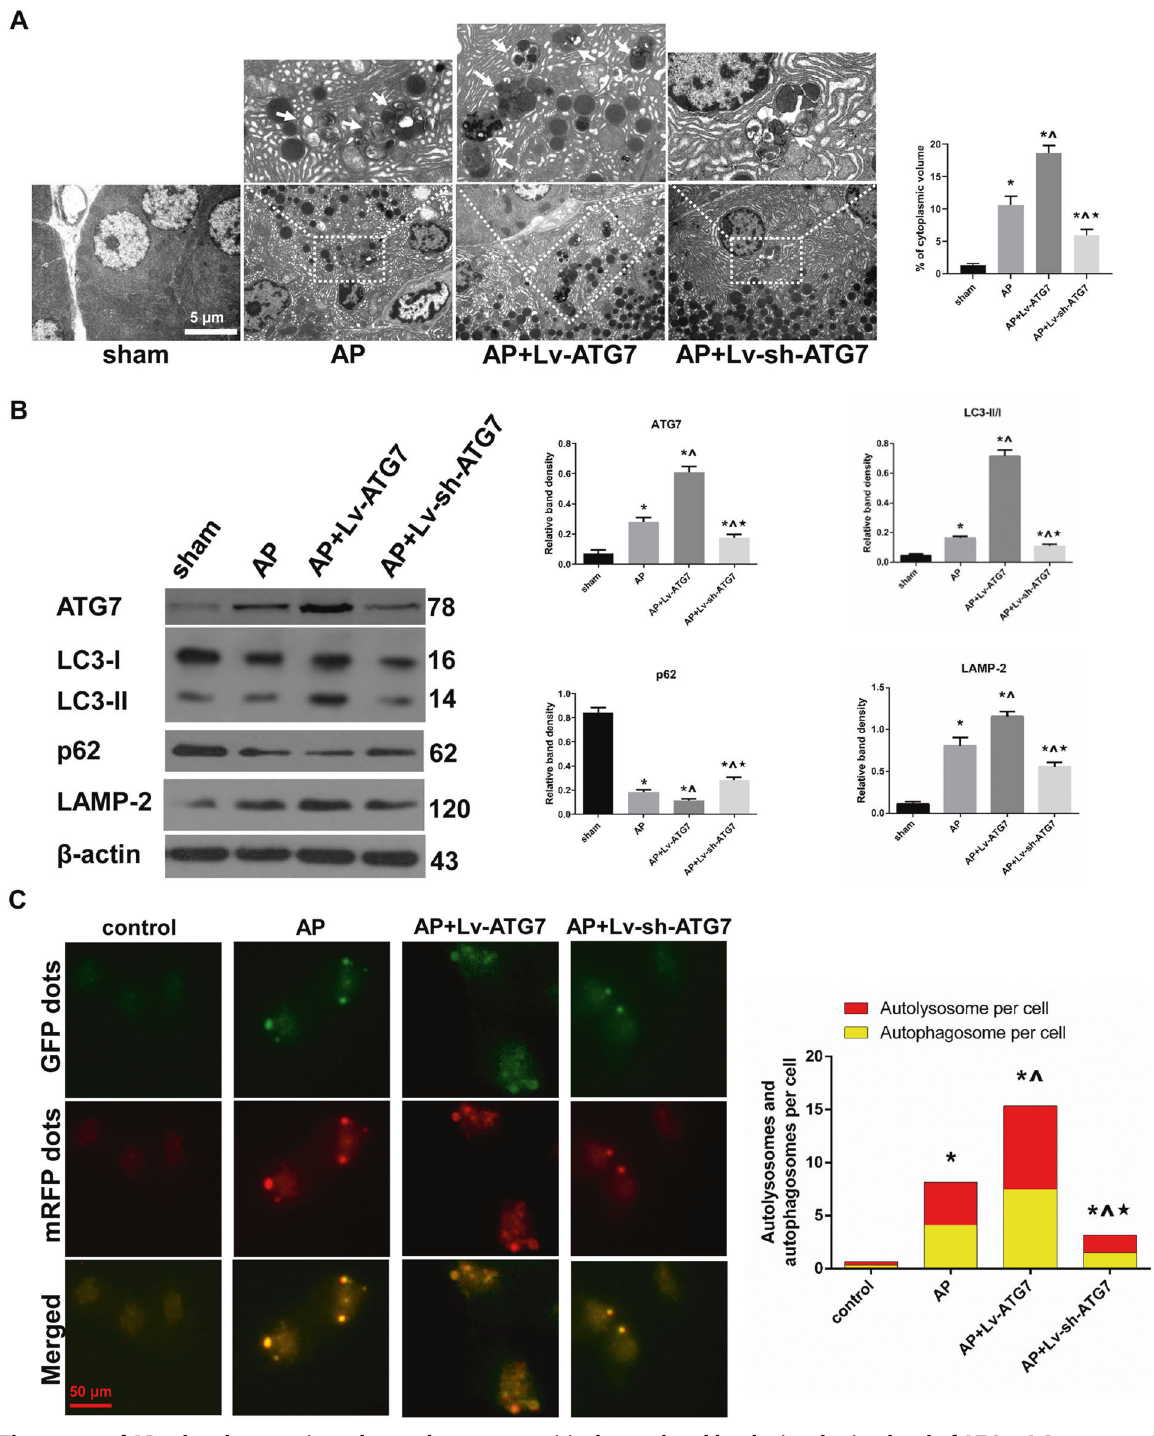
Fig. 2 The extent of AP-related overactivated autophagy was positively regulated by the incubation level of ATG7. A Representative TEM photos of pancreatic tissues harvested from the rats that were subjected to sham operation, AP, AP + Lv-ATG7 and AP + Lv-sh-ATG7 for 6 h since AP induction. The percentage of autophagic vacuoles (white arrows) per cytoplasm area was calculated. Bar = 5 μ m. B Representative Western blot images and quanti fi cations of ATG7, p62, LAMP-2 protein expression and LC3 conversion in pancreatic tissues as described above. β -actin was used as the protein loading control. C Representative fl uorescent photographs of autophagy fl ux assay in mRFP-GFP-LC3 tagged AR42J cells that were subjected to control, AP, AP + Lv-ATG7 and Lv-sh-ATG7 for 3 h since AP induction. The number of autophagic dots and ratio of red dots (autolysosomes) to yellow dots (autophagosomes) per cell was calculated. Bar = 50 μ m. Data were presented as mean ± SD ( N ≥ 3). ∗ P < 0.05 versus sham or control, ^ P < 0.05 versus AP, and * P < 0.05 versus AP + Lv − ATG7. AP acute pancreatitis, CAMKII calcium/calmodulin-dependent protein kinase II, LAMP-2 lysosome-associated membrane protein-2, LC3 microtubule-associated protein 1 light chain 3, SD standard deviation, TEM transmission electron microscopy.